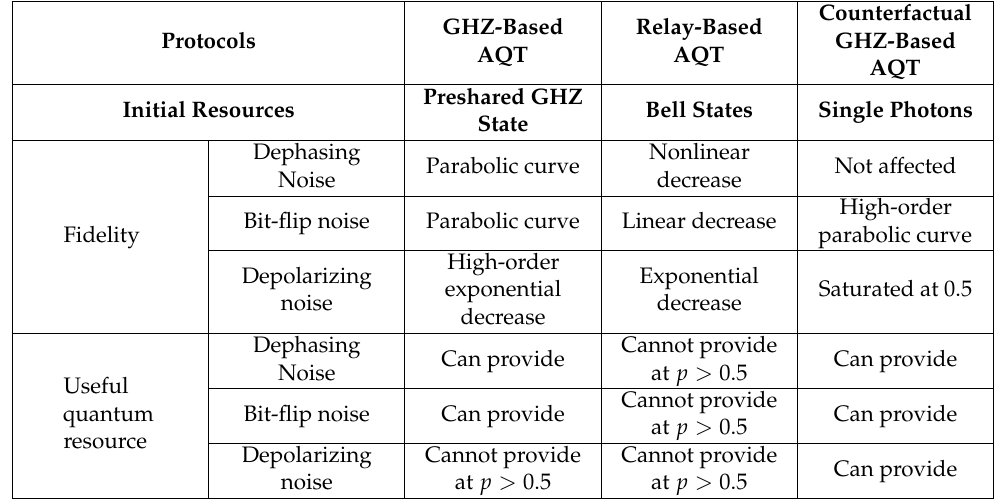
Table 1. Performance comparison of AQT protocols under three different types of channel